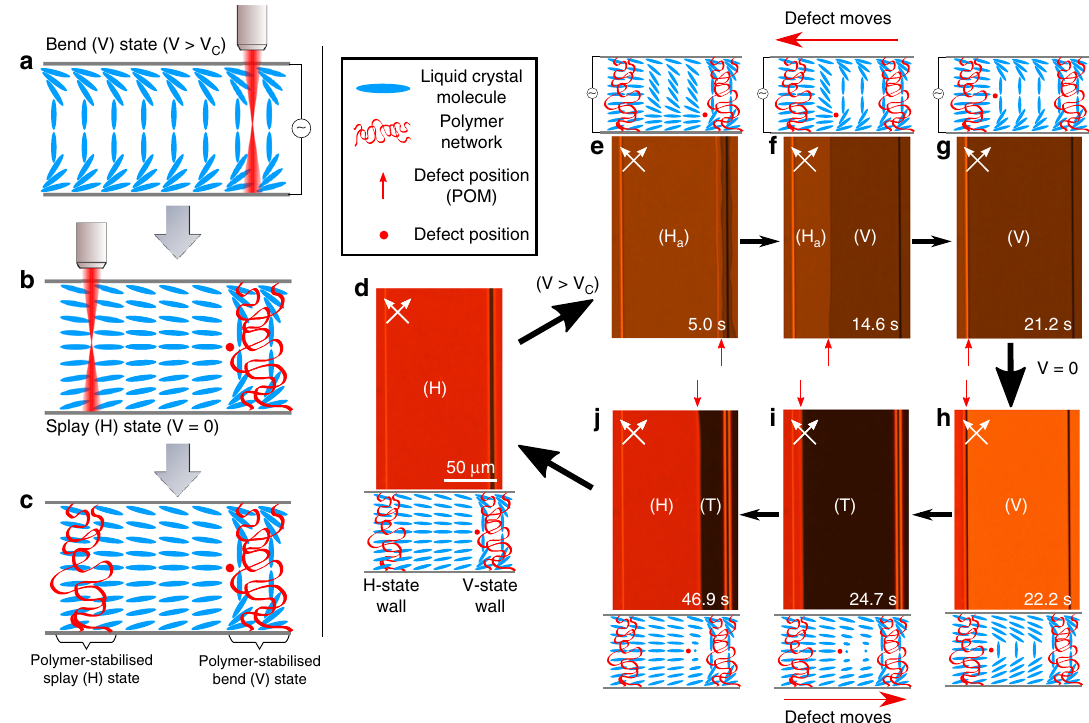
Fig. 1 Electrically-tunable disclination line. Left: Schematic of the fabrication procedure showing a cross-section of the LC device. Blue rods show the orientation of liquid crystal molecules, red circles indicate the defect position and red ribbons represent polymer network. a Initially the device is driven into the bend state (V-state) by applying a voltage above V c , before 2PP-DLW is used to create a polymer wall stabilised in the V-state. b The applied voltage is removed and the device relaxes to the splay state (H-state). A defect forms next to the V-state wall, separating the topologically discontinuous states. 2PP- DLW is then used to fabricate a polymer-stabilised H-state wall 100 µ m from the fi rst wall. c The fi nal con fi guration of the device, with two parallel polymer-stabilised walls, in the topologically discontinuous H and V states, respectively, separated by a gap of 100 µ m. Right: Polarising optical microscopy (POM) images and director pro fi les showing the dynamics of the tunable disclination line under an applied voltage. Red arrows highlight the position of the defect line in each POM image. d With no voltage applied, the bulk of the device is in the H-state and the defect is adjacent to the V-state wall. e – g A voltage above V c is applied to the device and the defect begins to move across the channel until it meets the H-state wall. h – j Removing the voltage causes the V-state to relax into a 180° twisted state (T-state), and the defect moves back across the channel. The H-state grows and moves across the channel with the disclination line at the frontier of the growing domain, until it is impeded by the polymer-stabilised V-state